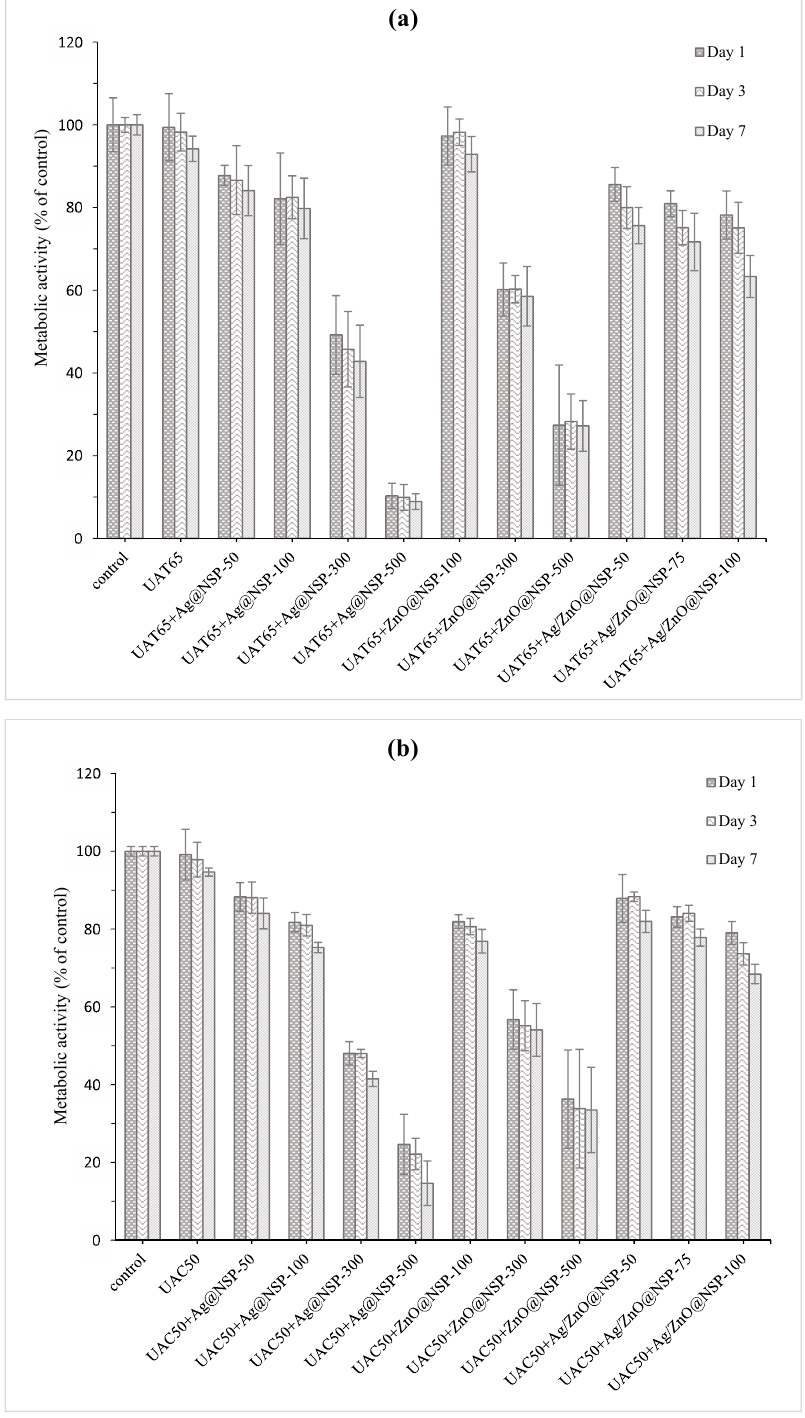
Figure 12. Alamar blue assay of ( a ) UAT65/TPGDA ( w/w = 70/30) and ( b ) UAC50/TPGDA ( w/w = 70/30) resins with various concentrations of Ag@NSP, ZnO@NSP, or Ag/ZnO@NSP (p < 0.05).